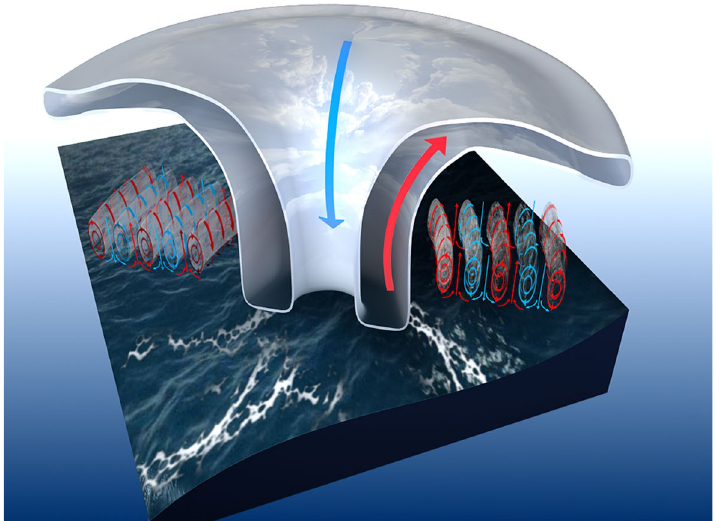
Figure 8. Schematic diagram of roll distribution in the tropical cyclone boundary layer based on aircraft observations in Typhoons Nida and